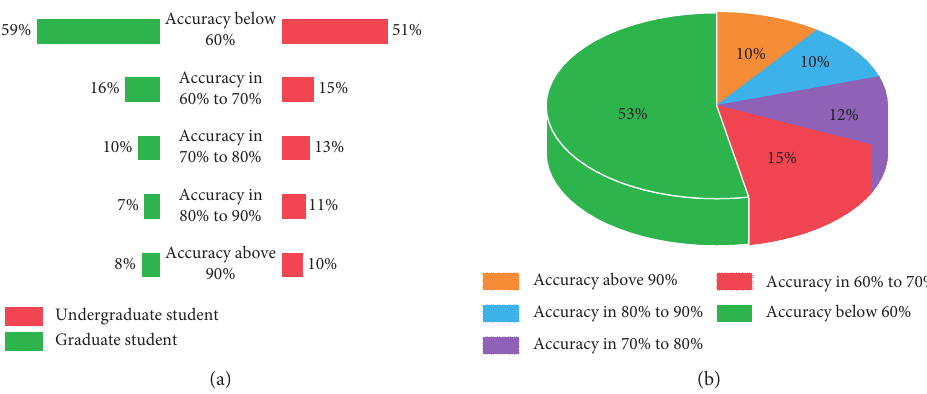
Figure 1: Accuracy rate of knowledge of handling representative emergencies.